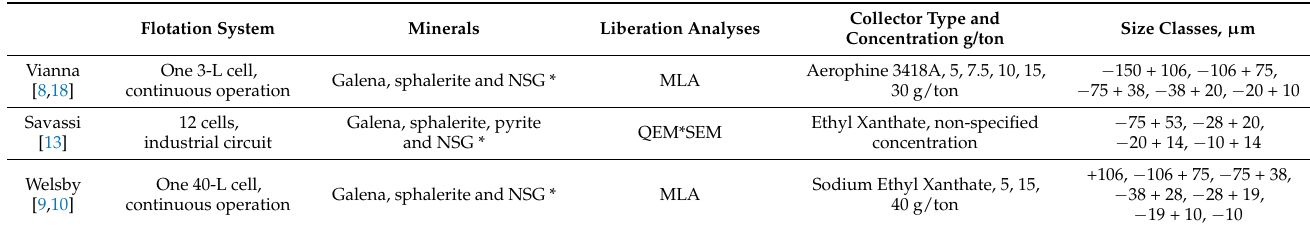
Table 1. Summary of experimental conditions, flotation feed and liberation